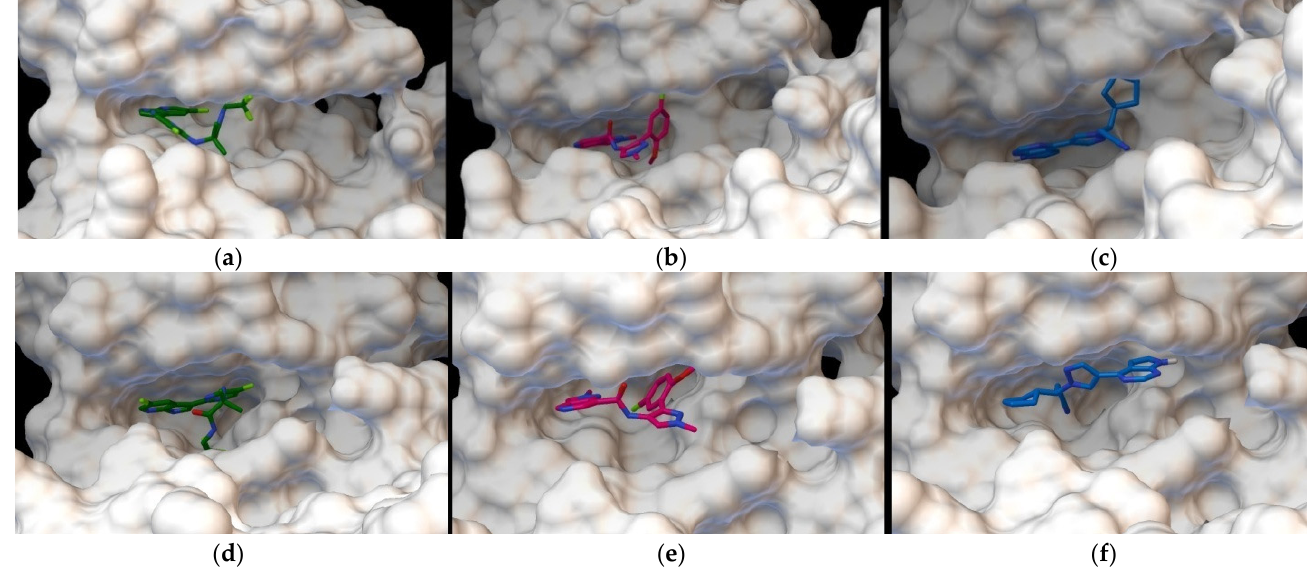
Figure 3. Ligand binding site and JAK1: ( a ) decernotinib, ( b ) KEV, and ( c ) ruxolitinib; ligands and JAK2: ( d ) decernotinib, ( e ) KEV, and ( f ) ruxolitinib (Supplementary materials, Figures S1–S6).